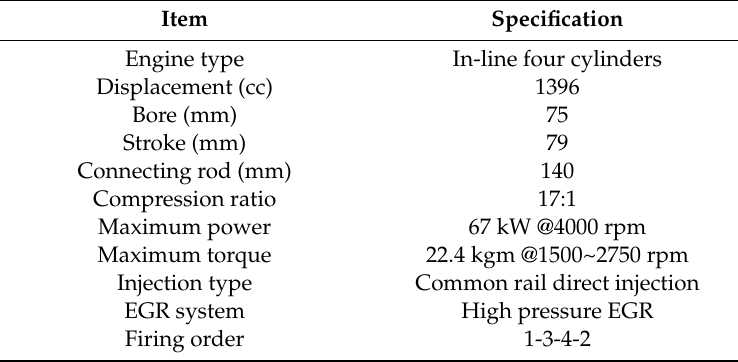
Table 2. Engine specifications.